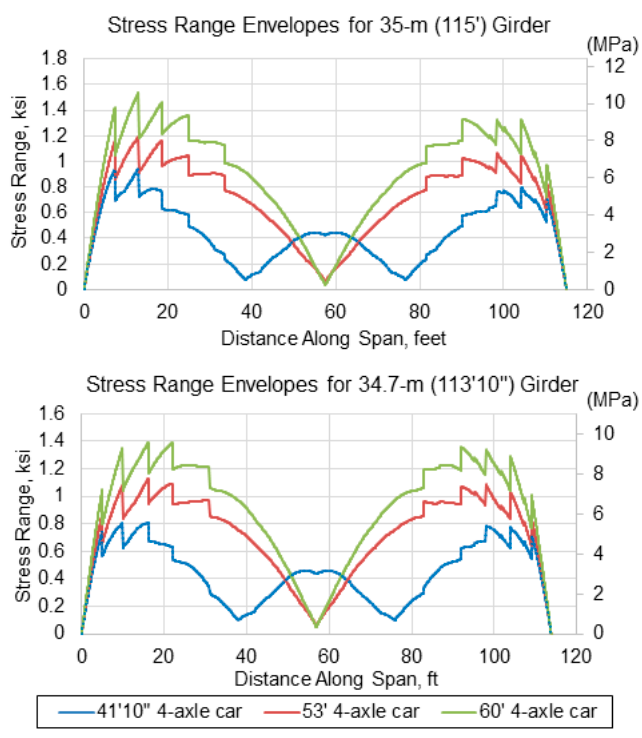
Figure 19. Calculated cyclic stress range envelopes.